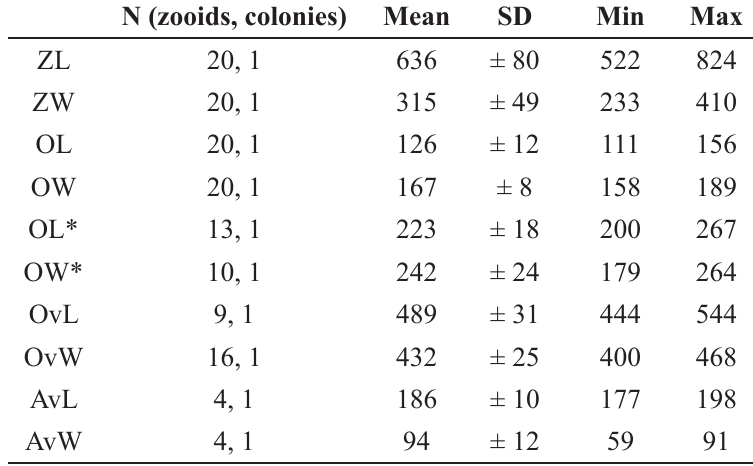
Table 1. Measurements in microns of Powellitheca terranovae gen. et